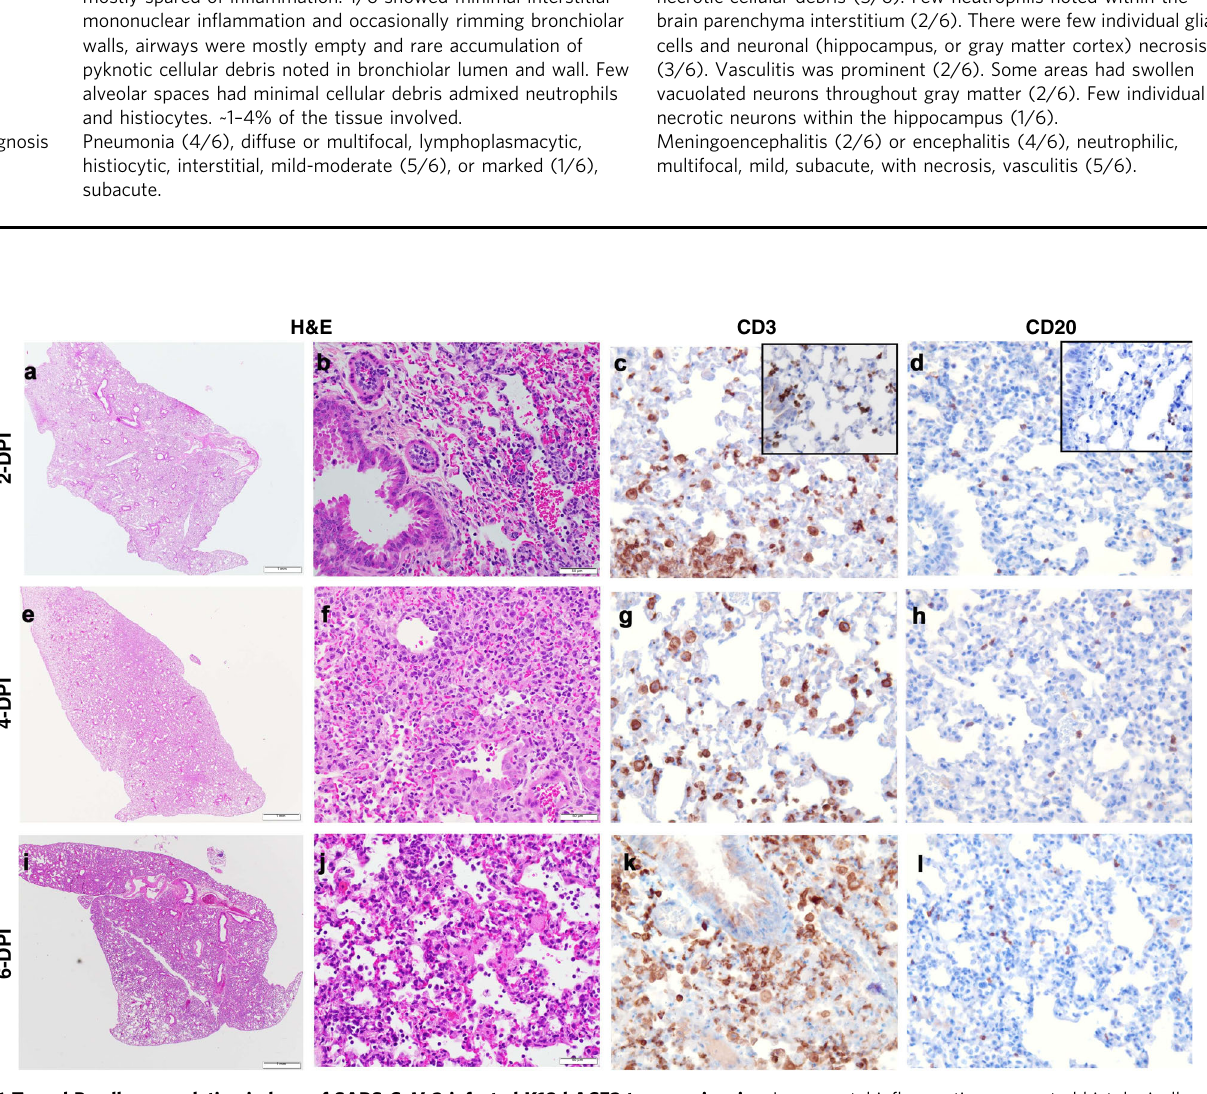
SARS-CoV-2 through the body to the points of CSF reabsorption. Results were further con fi rmed by double staining (Fig. 8c – e) showing that co-localization of hACE2 with SARS-CoV-2 NP occurred primarily in the lungs, being more focalized in the nasal turbinates and brain. In the brain SARS-CoV-2 NP appeared in cell bodies of cortical neurons, a speci fi c population of Pyramidal neurons in the cerebral cortex.